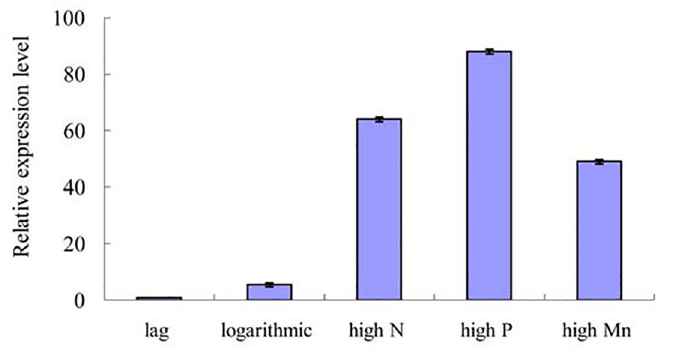
Fig 7. qPCR validation of the differentially expressedtae-miR159a.